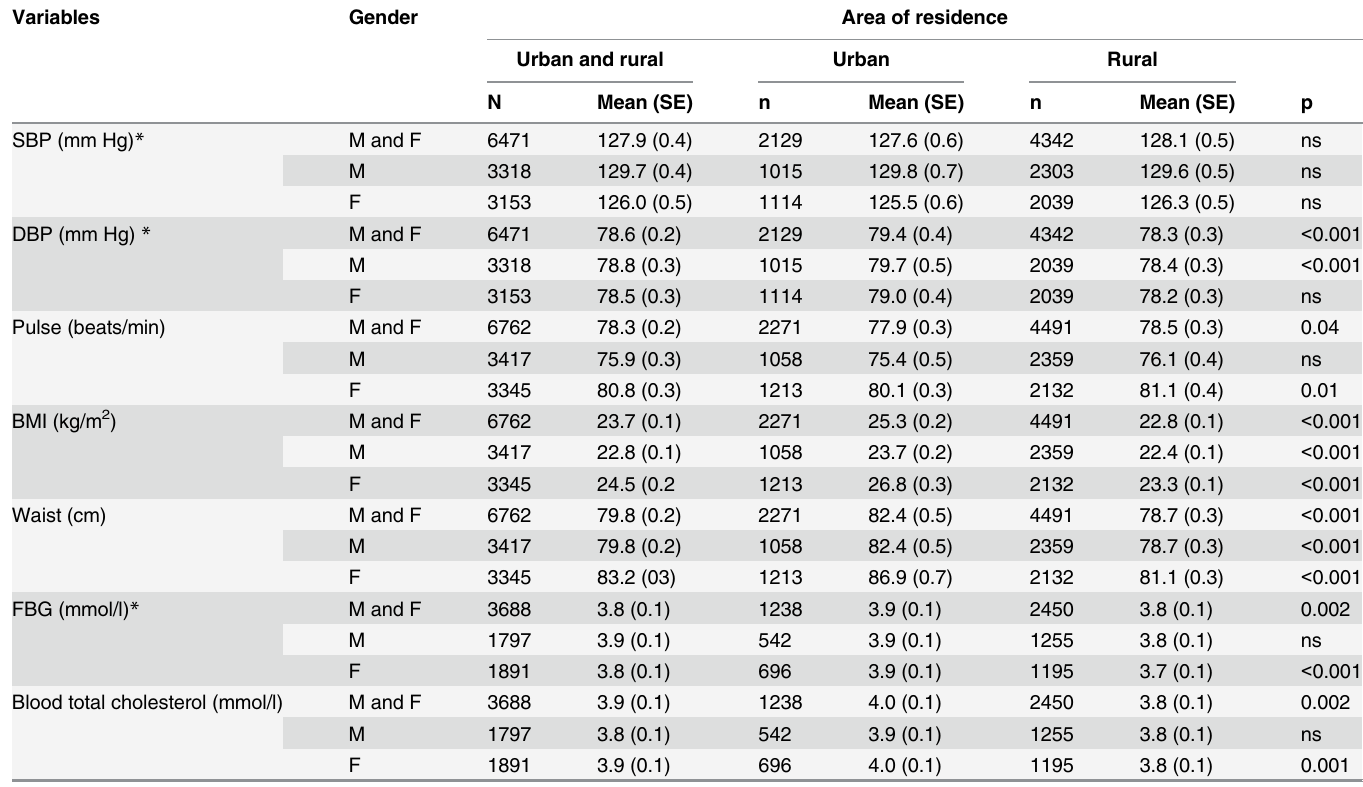
Table 3. Means of anthropometrics and biological parameters in 25 – 64 year old population in Benin, stratified by area of residence and gender. Variables